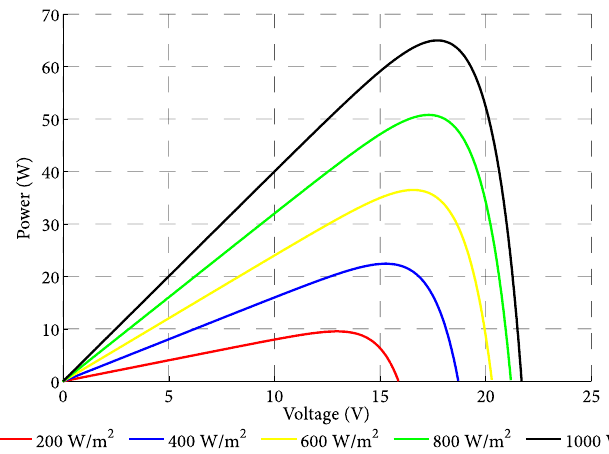
Figure 1. I-V curve of the PV module under different solar radiances.